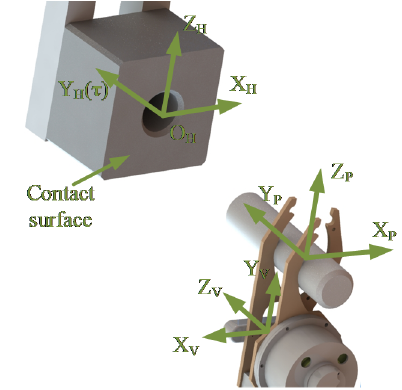
Figure 5. Definition of the HCS.